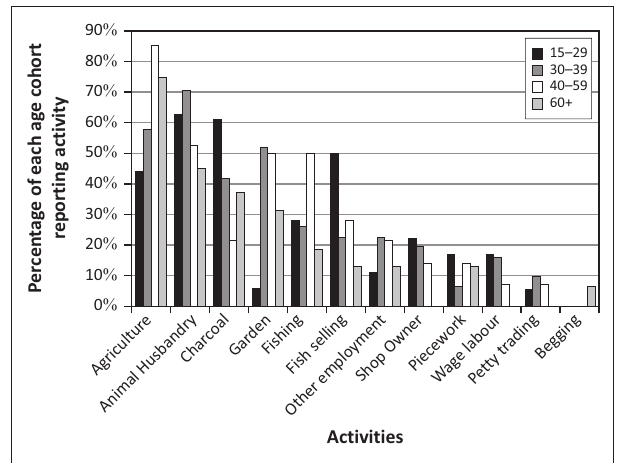
FIGURE 8: Livelihoods activities by age in Kasaya.